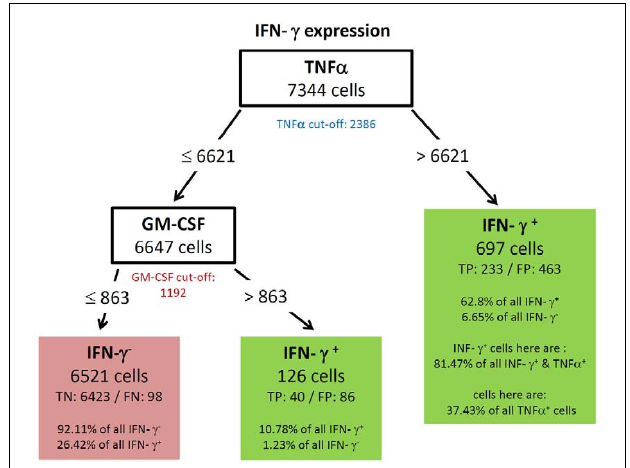
FIGURE 6 | Best decision tree for the classification of cells as positive or negative for IFN- γ expression. Cells are classified based on the MFI values of firstTNF- α and second GM-CSF.The blue coloredTNF- α (red colored GM-CSF) cut-off value indicates that the split value is high above (below) the cut-off value.Therefore, these nodes dived the cells not just in TNF- α (respectively GM-CSF) negative and positive cells. Only a proportion of the cells which expressTNF- α are routed to the right leaf. Contained in this leafs are only 37.43% of allTNF- α positive cells due to this high split value compared to the cut-off value.This leaf captures 62.8% of the IFN- γ positive cells, these are 233 cells (TP – true positive).The leaf also contains the information that this leave captures 81.47% of all IFN- γ andTNF- α positive cells.The leaf in the middle classifies cells as IFN- γ positive and captures 10.78% of all IFN- γ positive cells.The left node classifies cells as IFN- γ negative, thus this leaf wrongly classifies 26.42% of the IFN- γ positive, but captures 92.11% of all IFN- γ negative cells.